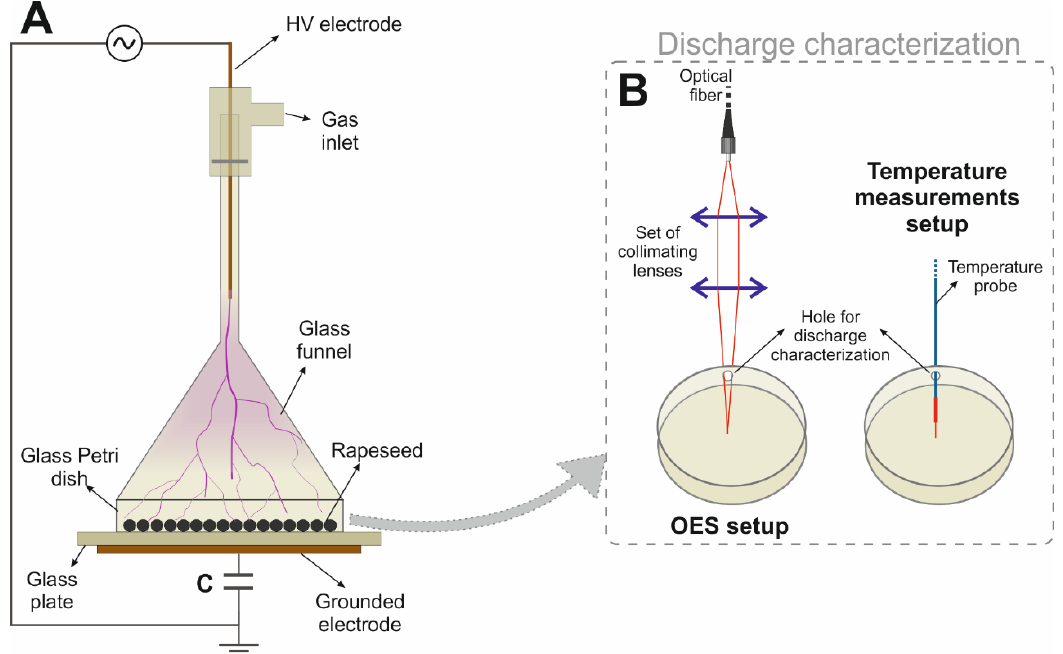
Figure 1. Experimental setup of the funnel reactor used in this study ( A ). Details of the discharge characterization setups for temperature and OES measurements are shown in ( B